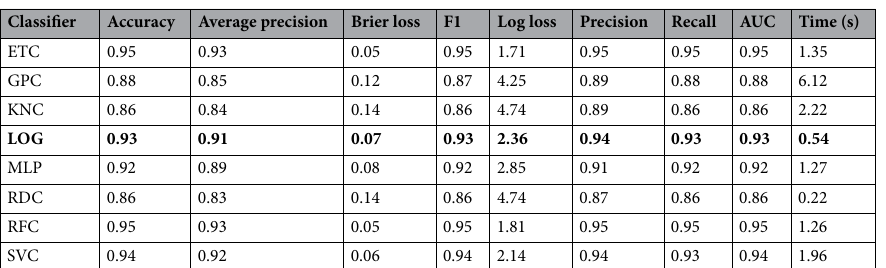
Table 3. Classifier comparison. Performance metrics for the 8 classifiers (Extra Trees Classifier, ETC; Gaussian Process Classifier, GPC; K-Nearest Neighbour, KNN; Logistic Regression, LOG; MultiLayer Perceptron Classifier, MLC; Ridge Classifier, RDC; Random Forest Classifier, RFC; and Support Vector Machine classifier, SVC; in descending order) used for the disambiguation in “Topic detection” for a random sample of 2000 genes. The metrics shown in this table were obtained by averaging the results on the validation set during the threefold cross validation. Subsequently, the results were averaged for a sample of 2000 genes. The logistic regression classifier (bold) was the fastest and second most accurate model for a random sample of 2000 genes and therefore it was selected as the default model to run the disambiguation on the remaining 17,082 human protein-coding genes. This high validation score verified that there was no over-fitting after the threefold cross-